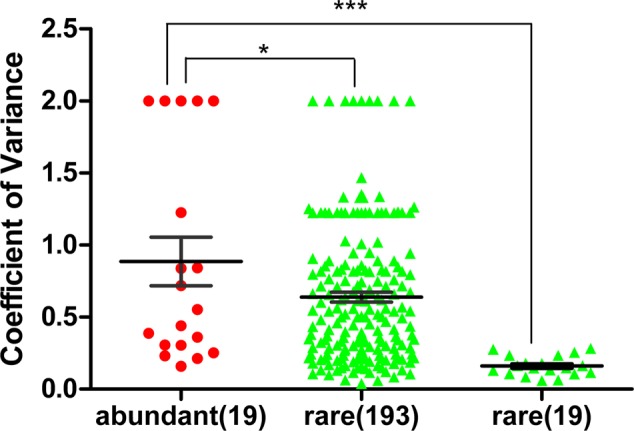
Coefficient of variation of abundant families and rare families at the five study sites (abundant OTU: >1%, and rare OTU: <0.1%). All 19 families of abundant bacteria, all 193 families of rare bacteria and the top 19 families of rare bacteria (ranked by the average proportion in the five sites) at the five study sites were analyzed. The mean coefficient of variation of the abundant families was significantly higher than that of the rare families (unpaired t-test, ∗∗∗p < 0.0001; ∗p < 0.05). Bar: mean ± SEM.